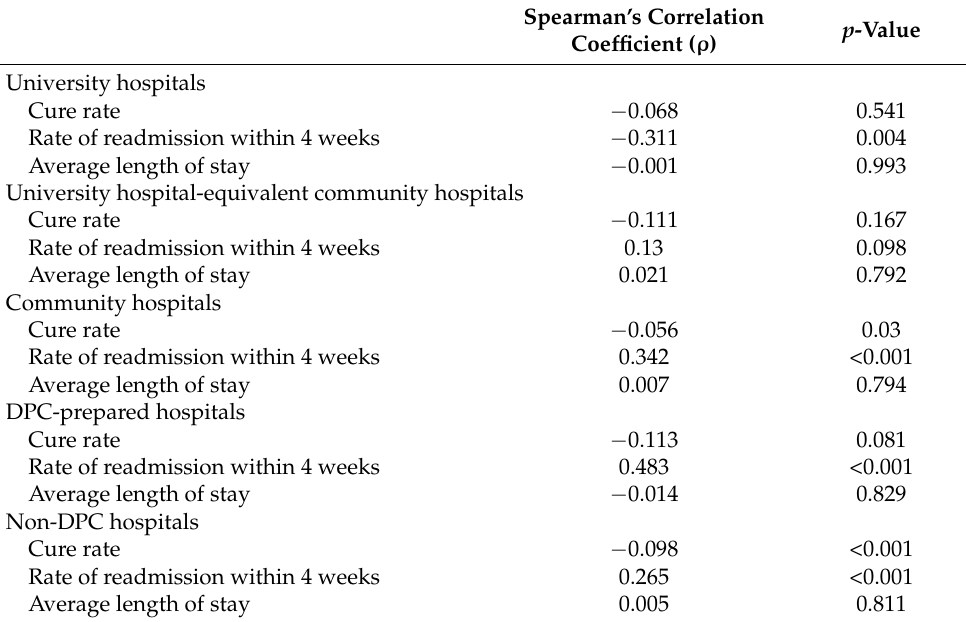
Table 2. Correlation analysis results of carbapenem consumption stratified by facility type, cure, readmission within 4 weeks, and average length of stay.